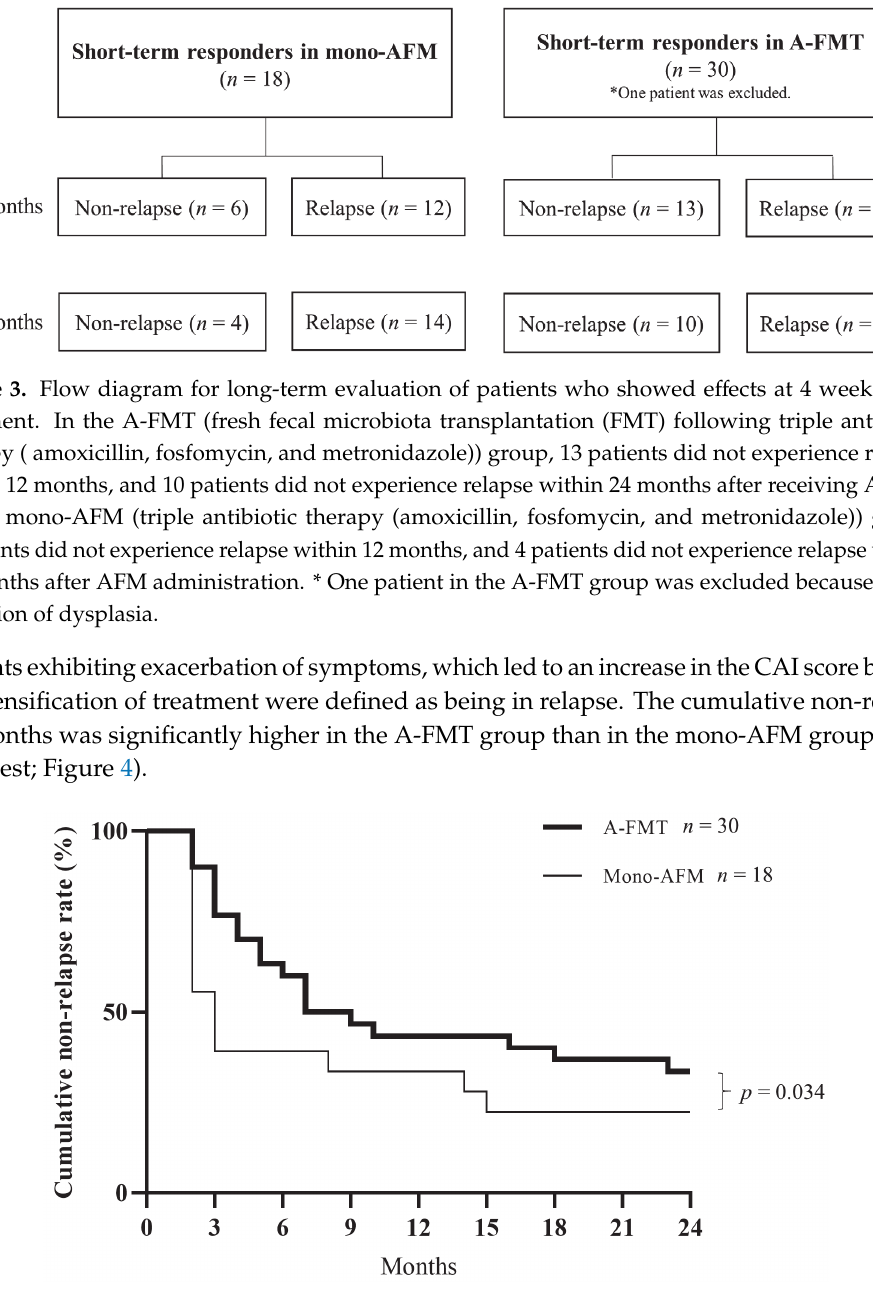
Figure 4. Comparison of cumulative non-relapse rate between the mono-AFM and A-FMT groups. The cumulative non-relapse rate for 24 months was significantly higher in the A-FMT (fresh fecal microbiota transplantation (FMT) following triple antibiotic therapy (amoxicillin, fosfomycin, and metronidazole)) group than in the mono-AFM (triple antibiotic therapy (amoxicillin, fosfomycin, and metronidazole)) group ( p = 0.034, Gehan-Breslow-Wilcoxon test).